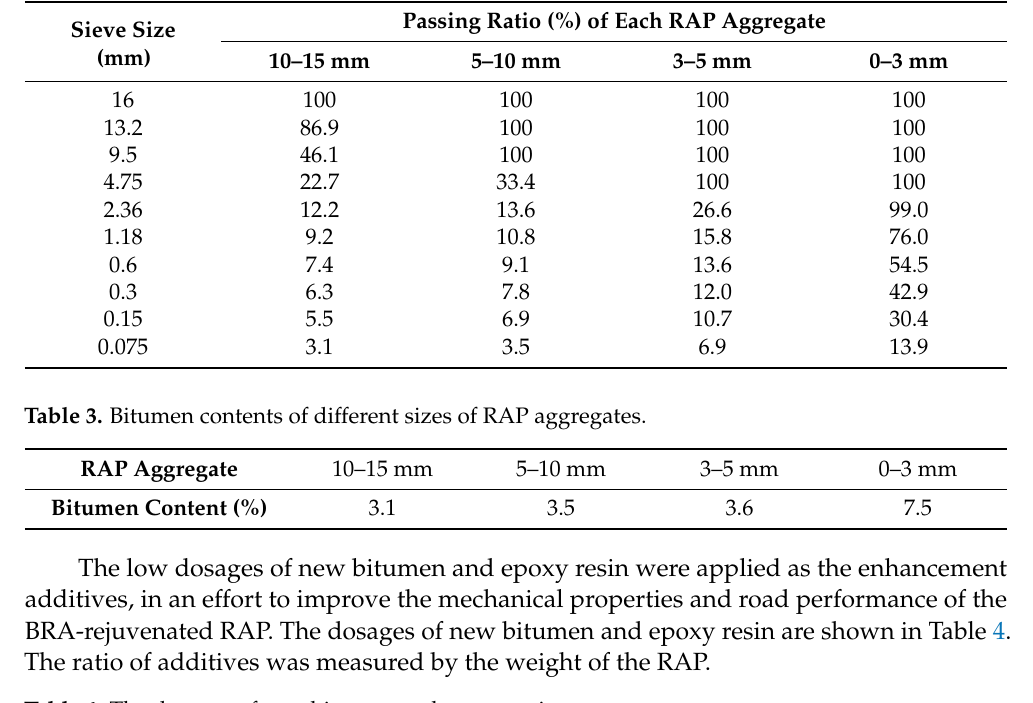
Table 4. The dosages of new bitumen and epoxy